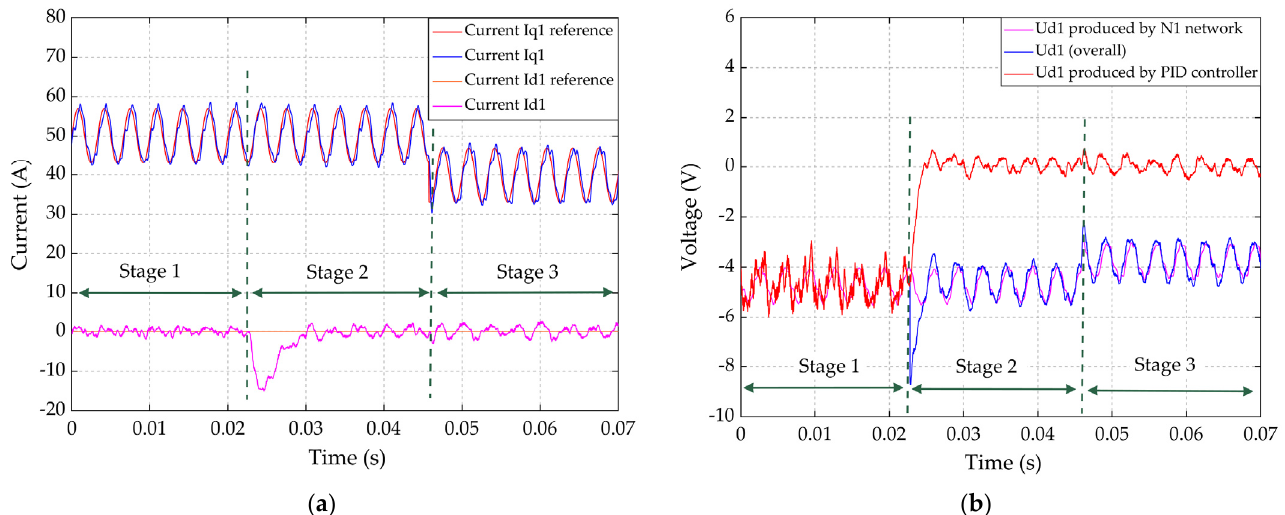
Figure 14. The dynamic response of the current and voltage on d/q -axis under HFR measurement and transient load change conditions in three stages: ( a ) Reference and sampled current on the d 1-axis and q 1-axis, ( b ) d -axis voltage produced by PID controller and the N1 network and their sum u d 1 . To verify the effectiveness of the decoupling network N2 across two wingding sets,